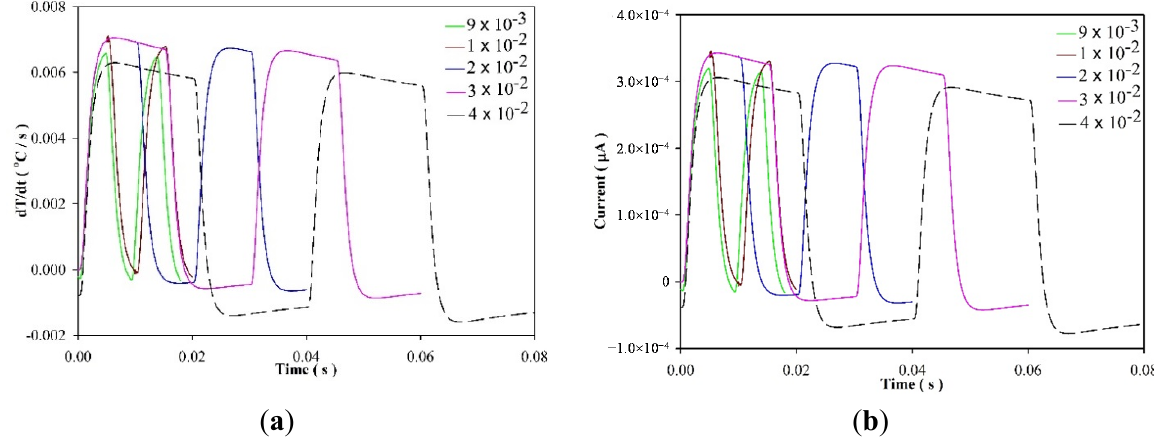
Figure 7. Relationships among ( a ) the temperature variation rate; ( b ) the current and time at five periods of 9 × 10 − 3 s, 1 × 10 − 2 s, 2 × 10 − 2 s, 3 × 10 − 2 s and 4 × 10 − 2 s for the 50 μ m thick PZT cell